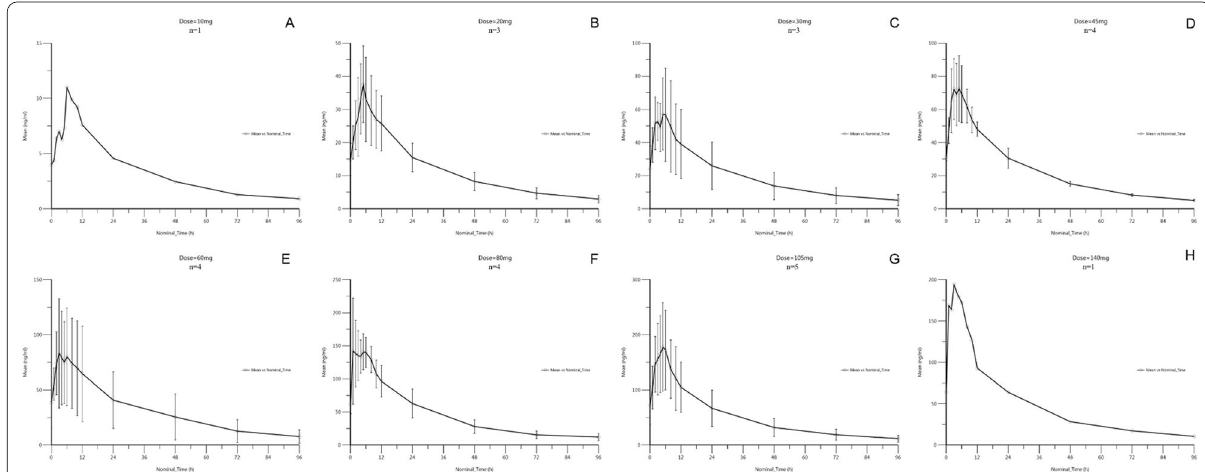
SD ± 1, B : n 3, C : n 3, D : n 4, E : n 4, F : = = = = =